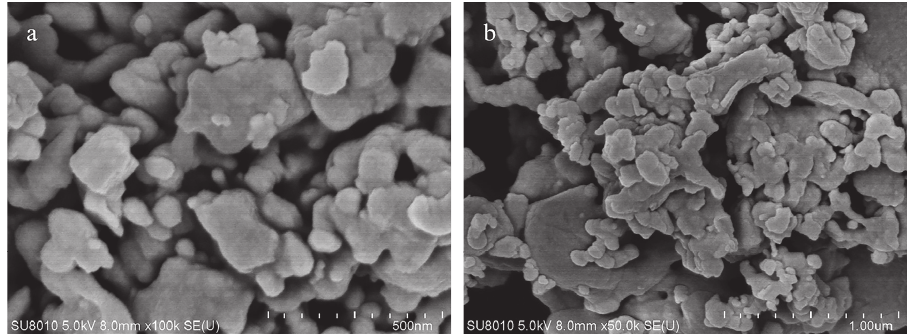
Figure 3: Morphology of adsorbent surface: (a) × 100000 and (b) × 50000.